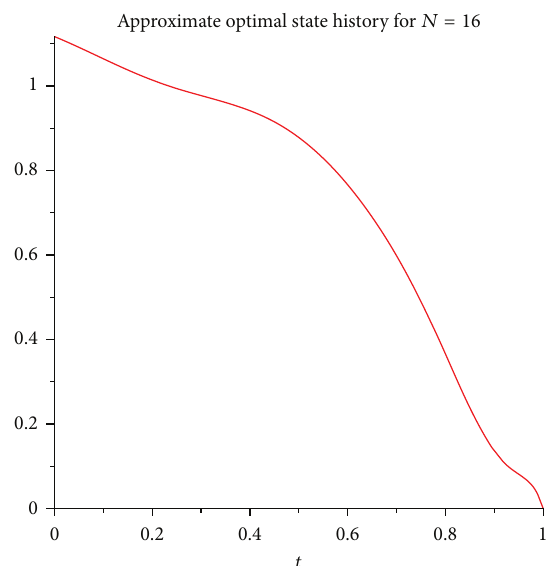
Figure 5: Approximate optimal state 𝑦(𝑡) history of Example 2 for 𝑁 = 16